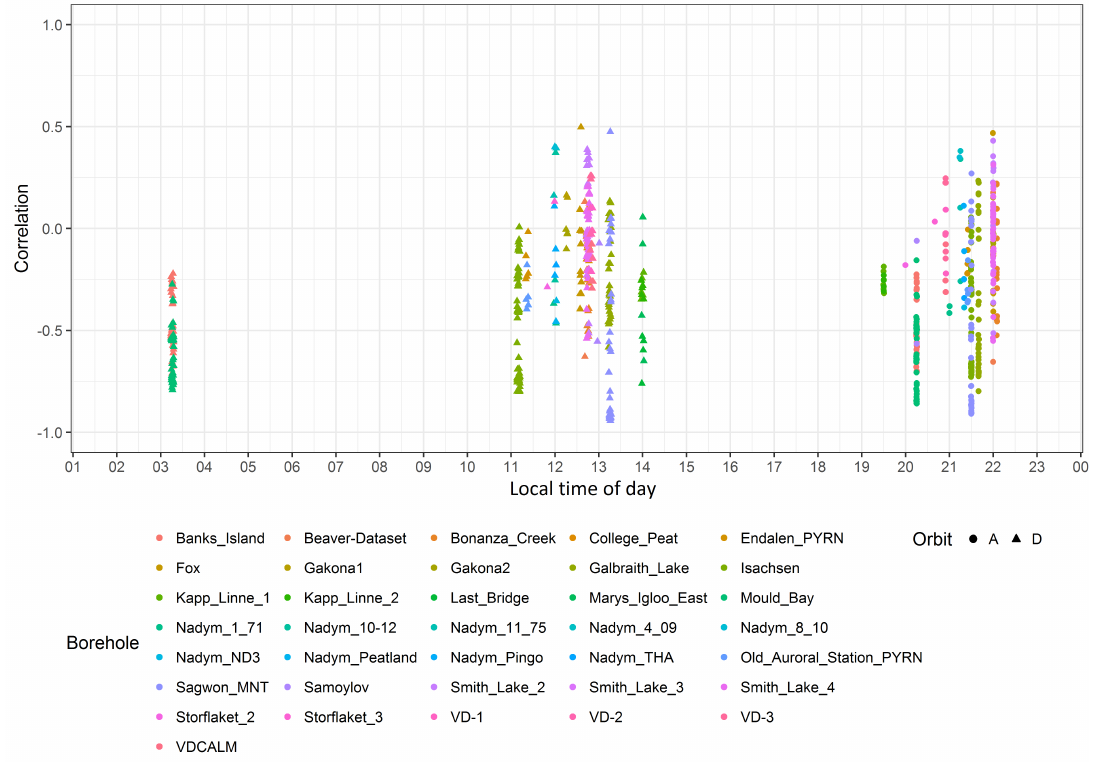
Figure 3. Correlations of ASCAT backscatter with ground temperature for the average acquisition times (local times) of ascending (A) and descending (D) orbits for the considered borehole sites (correlations shown here cover results from all considered